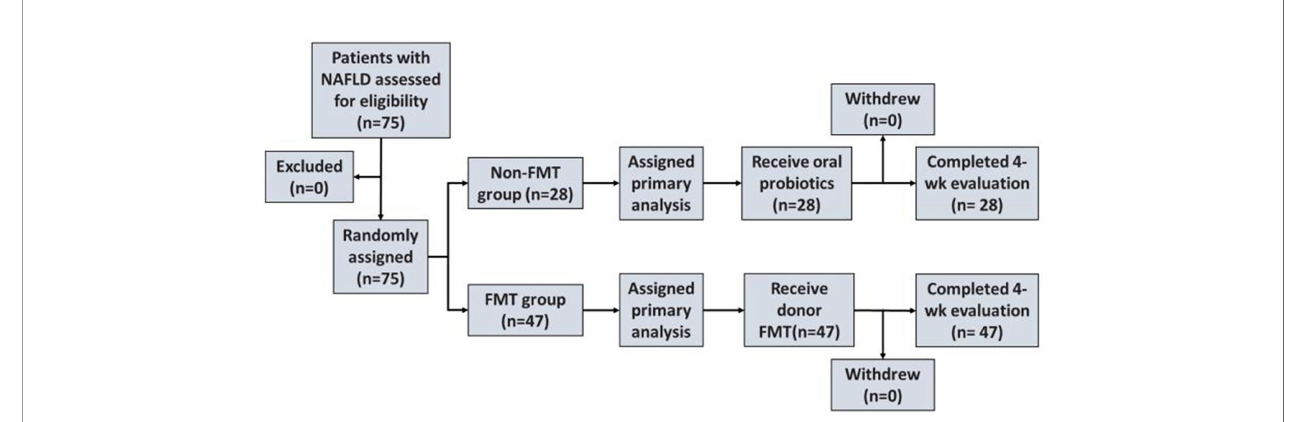
FIGURE 1 | Enrollment and outcomes. NAFLD, non-alcoholic fatty liver disease; FMT, fecal